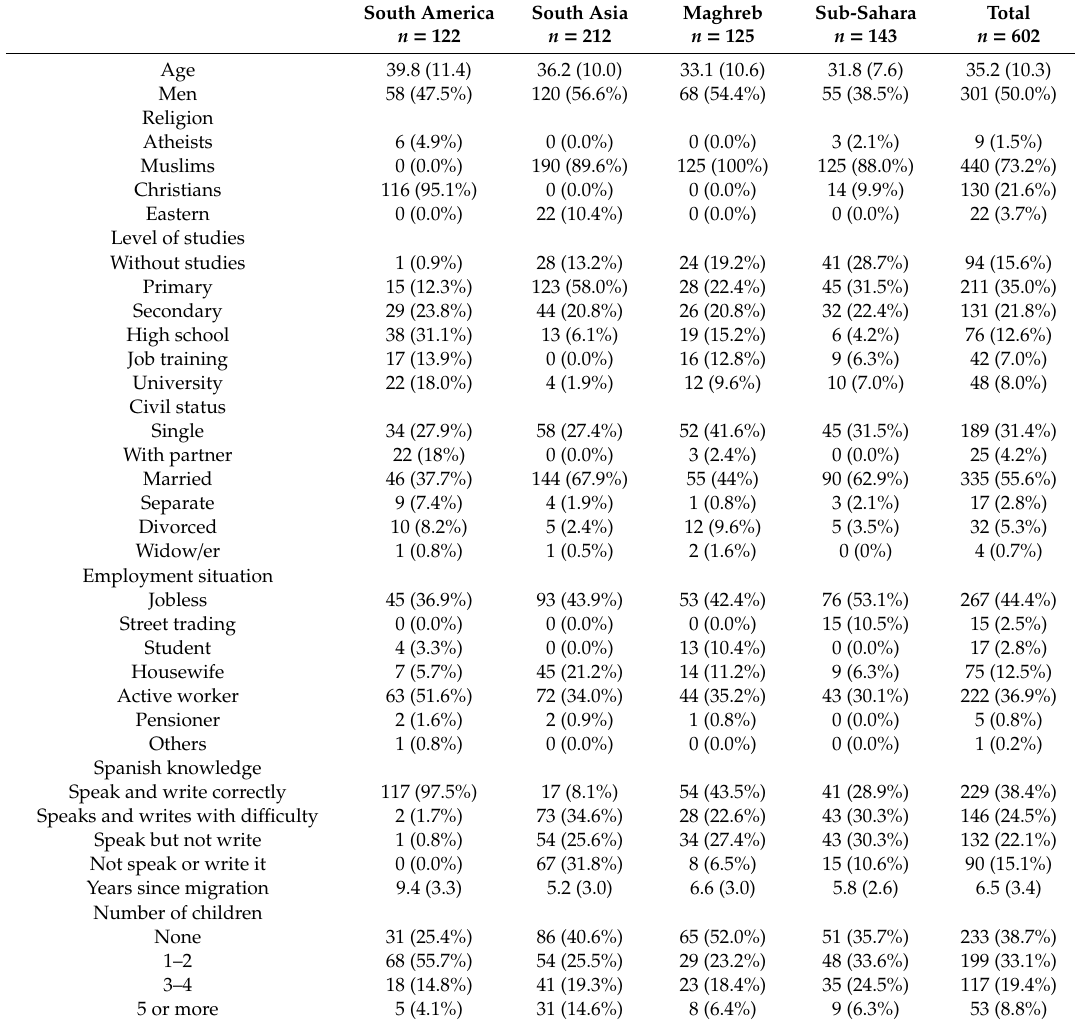
Table 1. Sociodemographic characteristics of the participants by